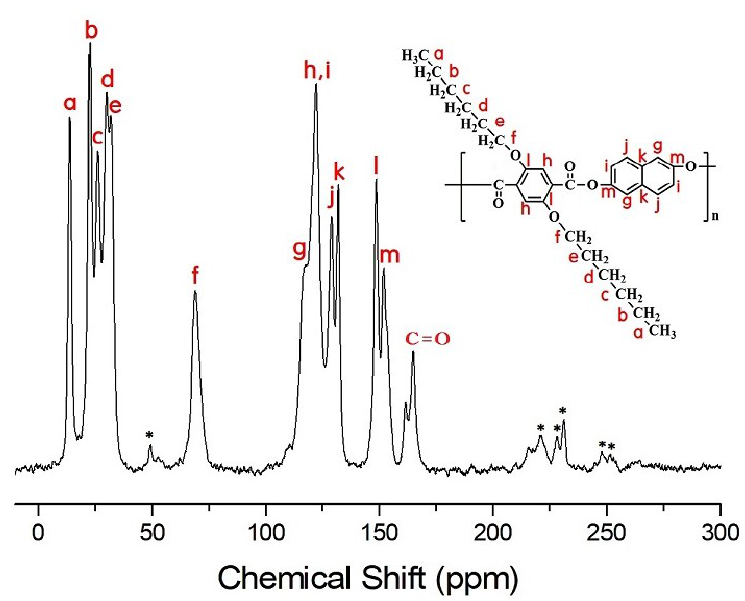
Figure 10. Solid state 13 C CP / MAS NMR spectrum of Naph-6 at room temperature. The spinning sidebands are marked with asterisks.